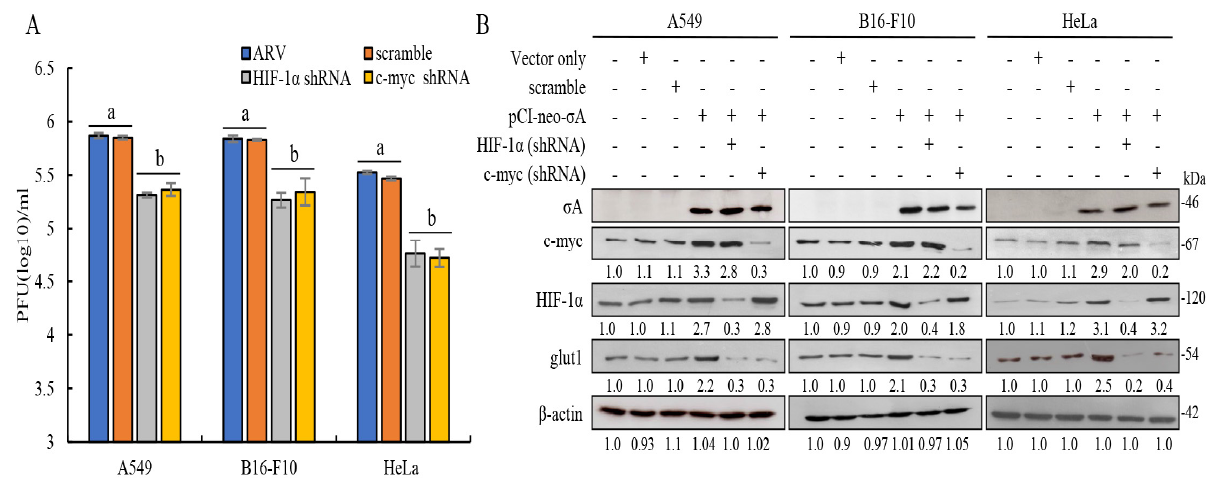
Figure 4. Knockdown of c-myc or HIF-1 α by shRNAs reduced the expression levels of glut1 and virus yields in these cancer cell lines. ( A )Three cancer cell lines were transfected with c-myc or HIF-1 α shRNAs for the first 6 h, later infected with ARV at an MOI of 10 for 24 h. Plaque assay was performed to analyze virus titers. Each value represents mean± SE from three independent experiments, determined using Duncan’s Multiple Range Test. Similar alphabets (a, b) denote no significance at p < 0.05. ( B ) Three cancer cell lines co-transfected with the pCI-neo- σ A and c-myc or HIF-1 α shRNAs for 24 h. Cell lysates were collected and examined using Western blots. Densitometry analysis results for Western blot are expressed as percentages representing levels of c-myc, HIF-1 α , and glut1 normalized to β -actin.